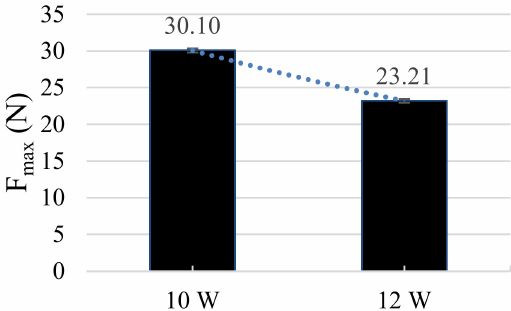
Figure 9. The Diagram illustrates a correlation between power and mechanical strength. A reduced ultrasonic power of 10 W leads to a higher mechanical strength.